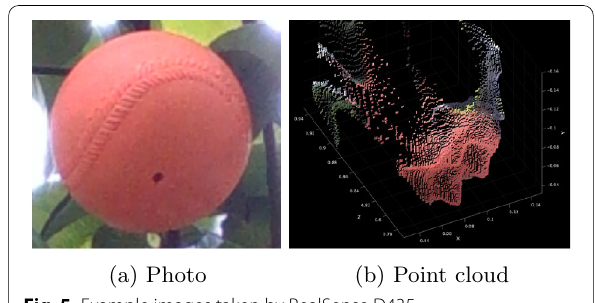
Fig. 5 Example images taken by RealSense